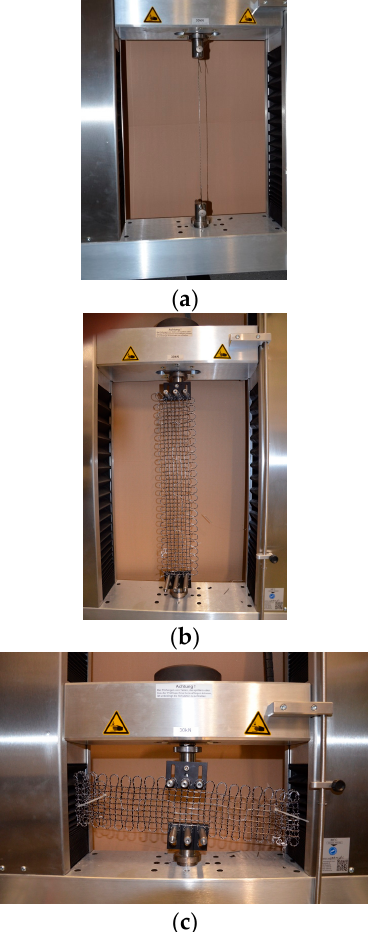
Figure 6. Functionalized 1D and 2D FCSs mounted to the tensile testing machine MFC T3000 in order to evaluate the force transfer between the carbon filament and the optical fiber ( a ) as well as the sensitivity to longitudinal ( b ) and normal ( c ) forces.